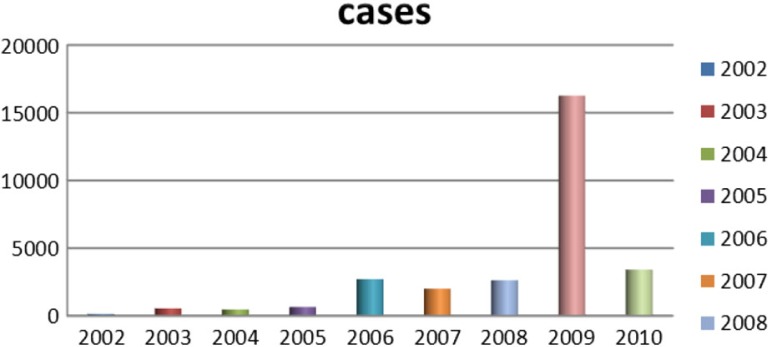
Annual distributions of DF cases in Hanoi (study period: 2002–2010).